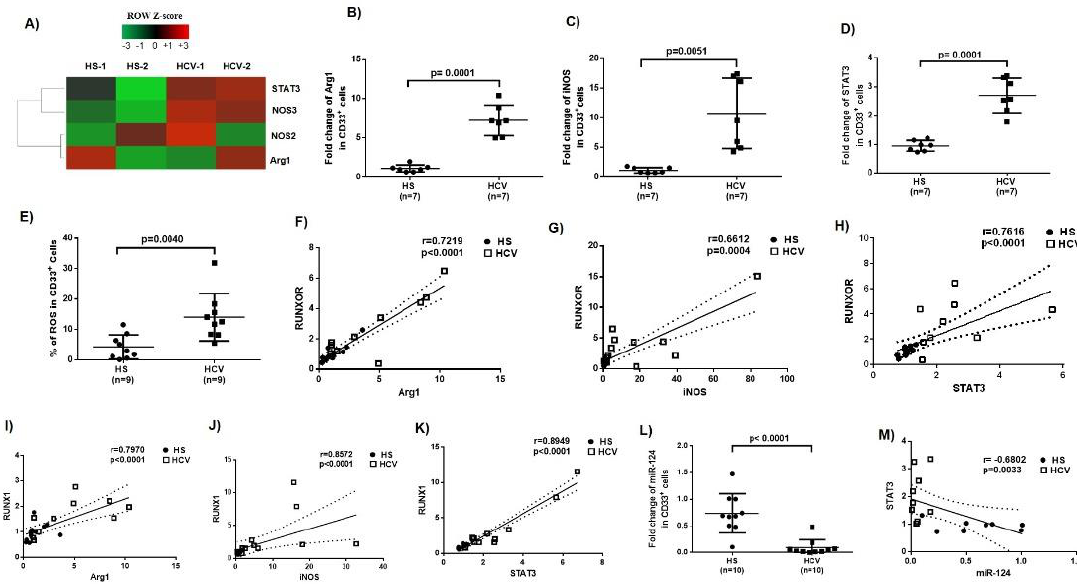
Figure 2. Upregulation of immunosuppressive molecules in MDSCs during HCV infection. ( A ) mRNA array showing upregulation of suppressive molecules (Arg1, NOS2, NOS3, and STAT3) in MDSCs from HCV-infected individuals. ( B – D ) Levels of Arg1, iNOS, and STAT3 gene expressions in CD33 + cells isolated from HCV-infected individuals versus HS, analyzed by real-time RT-qPCR. ( E ) ROS production in CD33 + cells derived from HCV-infected individuals versus HS, analyzed by the H2DCFDA assay. ( F – K ) The relationship between RUNXOR or RUNX1 and Arg1, iNOS, or STAT3 expression levels, analyzed by Pearson Correlation analysis. ( L , M ) Expressions of miR-124 in CD33 + cells from HCV-infected individuals versus HS, and correlation of miR-124 levels with STAT3 expression in these cells.